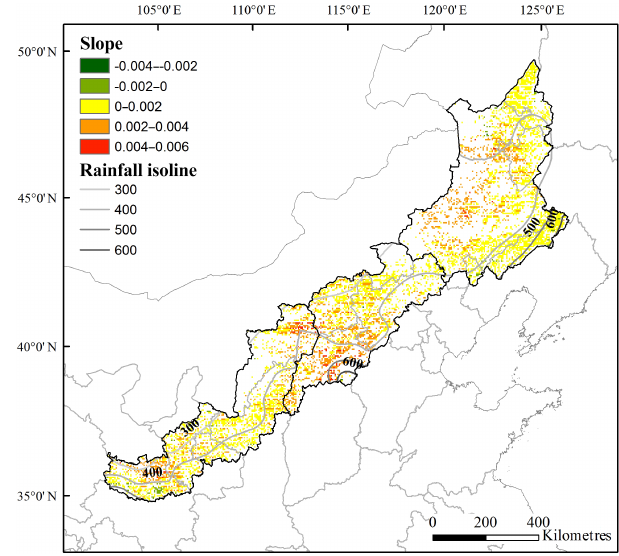
Figure 7. Slope of the linear regression of spring maize drought hazard intensity index from 1966 to